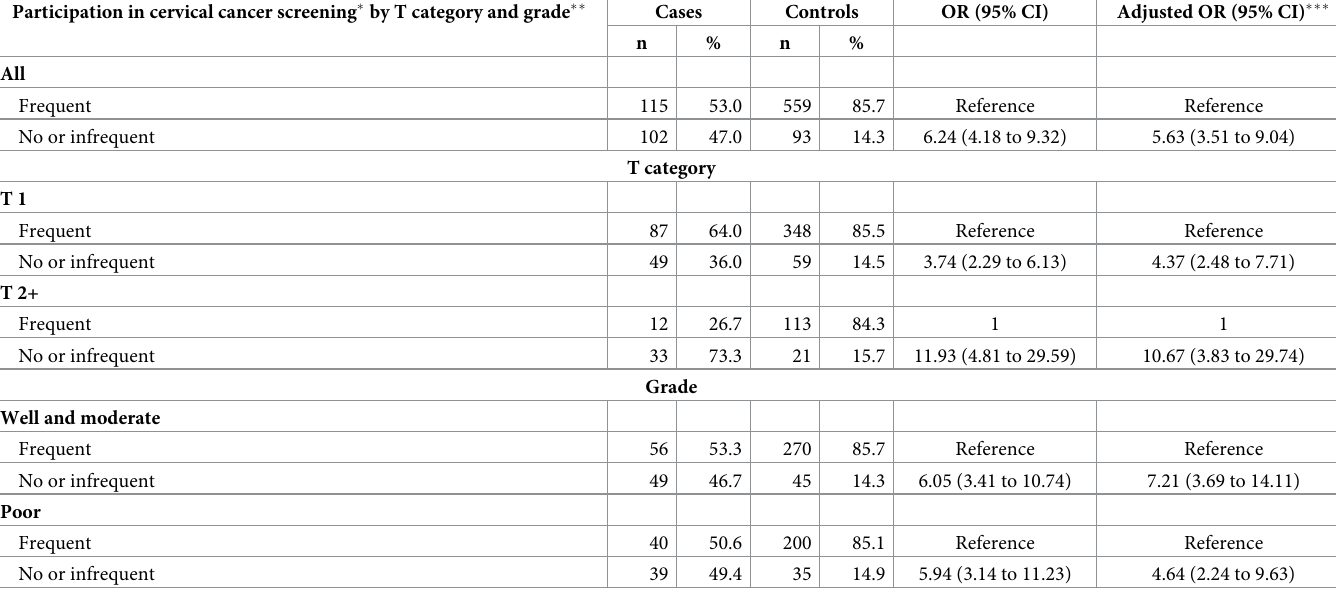
Table 2. Participation in cervical cancer screening during the past ten years among cases and controls (217 cases and 652 controls). Participation in cervical cancer screening � by T category and grade ��